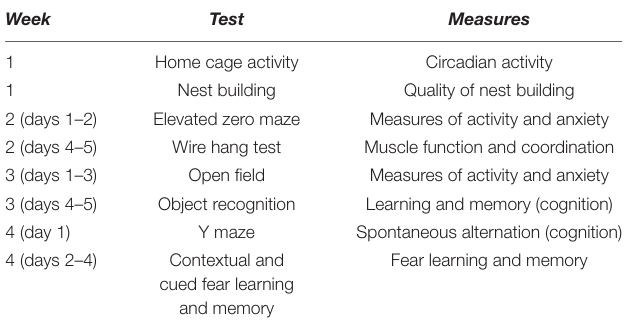
TABLE 2 | Overview of behavioral and cognitive